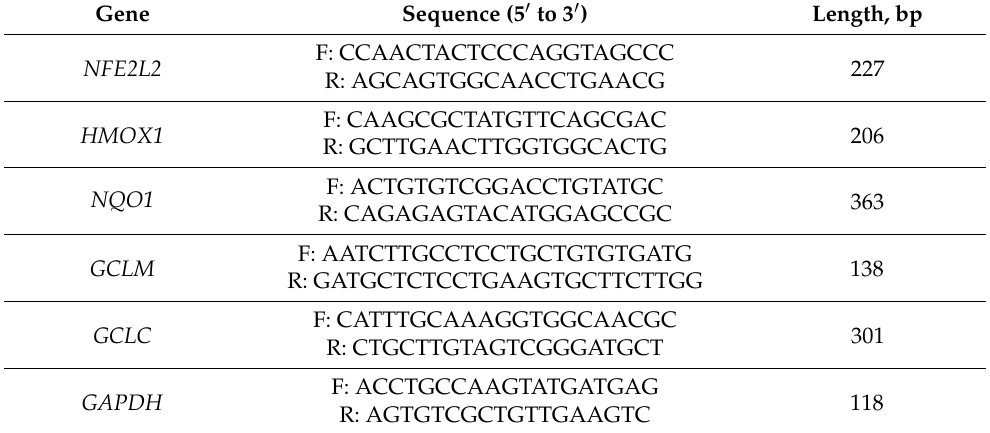
Table 1. Primer sequences for RT-qPCR.